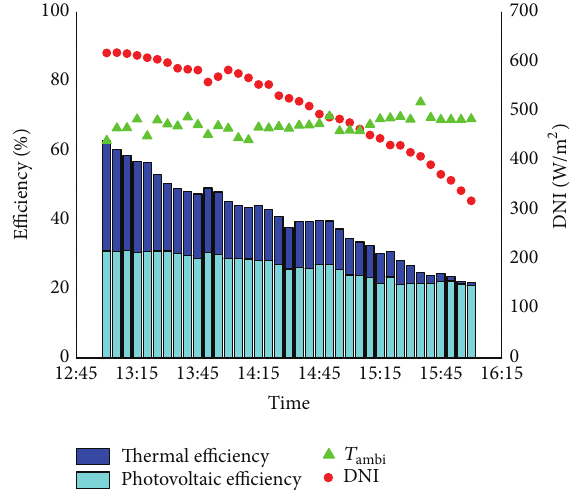
Figure 9: Efficiency characteristics of the HCPV/T system in the testing